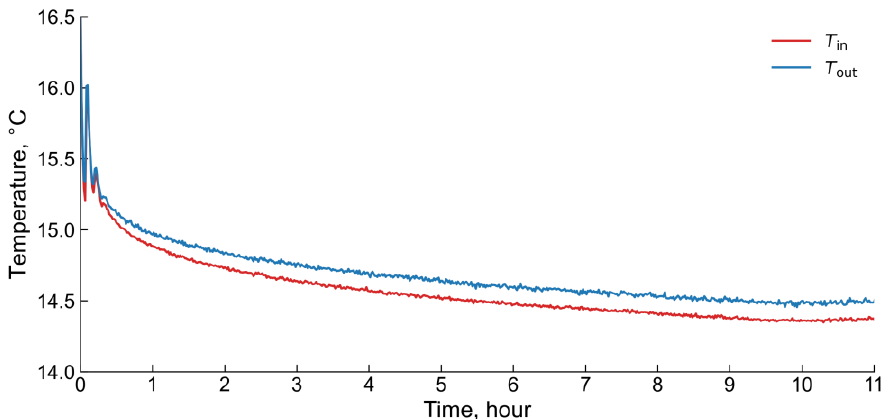
Figure 6. Undisturbed reference temperature of the ground.